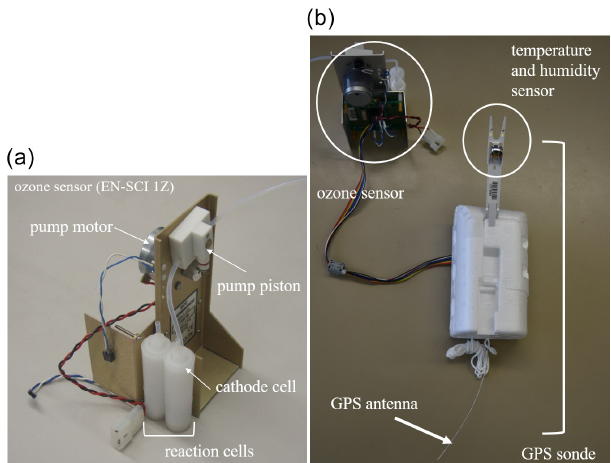
Figure 1. ECC-type ozonesonde ozone sensor (a) and connected GPS sonde (b) .